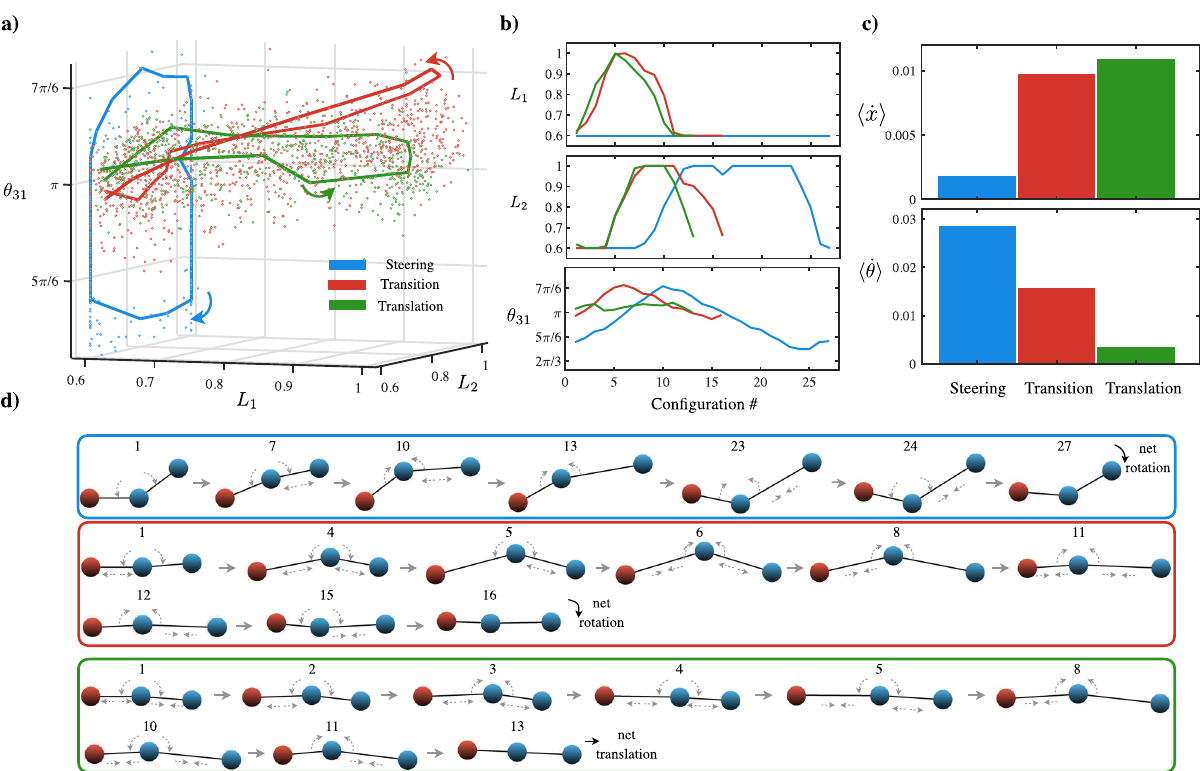
Fig. 3 Analysis of con fi gurational changes revealing three distinct modes of locomotory gaits. The steering, transition, and translation gaits are marked as blue, red, green, respectively. a A 3D con fi guration plot for a typical simulation which the swimmer aligns with the target direction via a counterclockwise rotation, where L 1 , L 2 are the arm lengths and θ 31 is the intermediate angle. Each dot represents one speci fi c con fi guration of a locomotory gait. The solid lines mark an example cycle of each locomotory gait. b The changes in the arm lengths L 1 and L 2 and the intermediate angle θ 31 with respect to the con fi guration number for each locomotory gait. c The average translational velocity h _ x i and rotational velocity h _ θ i are calculated by averaging the centroid translation along the target direction θ T and the change of swimmer's orientation θ o over the total number of action steps for each locomotory gaits. d Representative con fi gurations labeled with the con fi guration number are displayed to illustrate the con fi gurational changes for each selected sequence of locomotory gaits for the steering (blue box), transition (red box), and translation (green box) modes. The leftmost sphere of the swimmer is marked as red and other two spheres are marked as blue to indicate the swimmer's current orientation. The gray arrows indicate the contraction/extension of the arms and the intermediate angle. For illustration, the reference frame of the con fi gurations are rotated consistently such that the left arm of the fi rst con fi guration is aligned horizontally in each sequence. The animation of counterclockwise and clockwise simulations are shown in the Supplementary Movies 2, 3 and 7, sequence of con fi gurational changes for each mode of gaits are shown as solid lines to aid visualization (Fig. 3a).